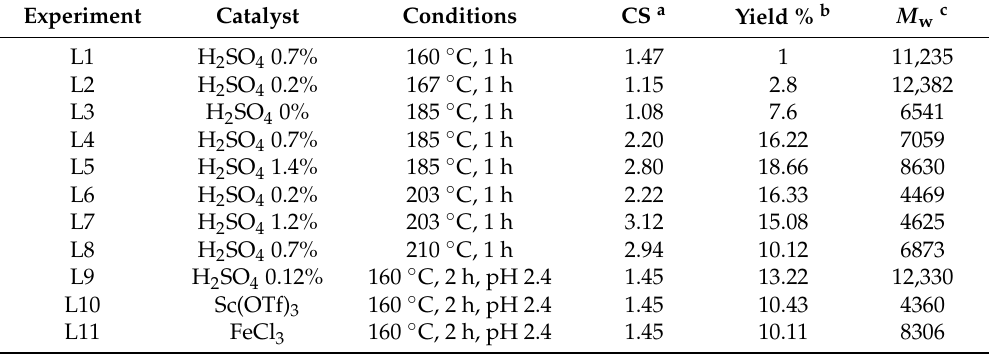
Table 1. Experimental conditions of the organosolv pretreatment evaluated for alfa, lignin yields, and molecular